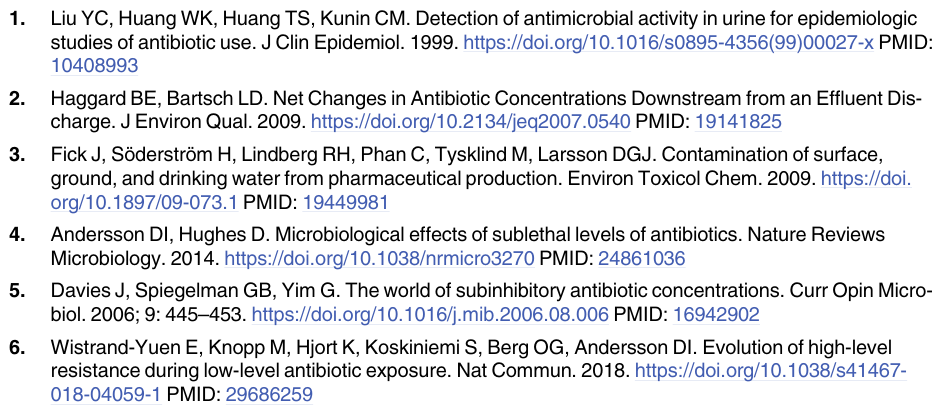
strains grown at OD 1.0. n = 3, error bars indicate SD. 600 S7 Fig. Overexpression of groESL-2 in the WT does not increase tolerance to tobramycin. Survival (after 7 hours TOB treatment) of WT strain carrying a control plasmid or a plasmid overexpressing groESL-2 genes. n = 6, error bars indicate